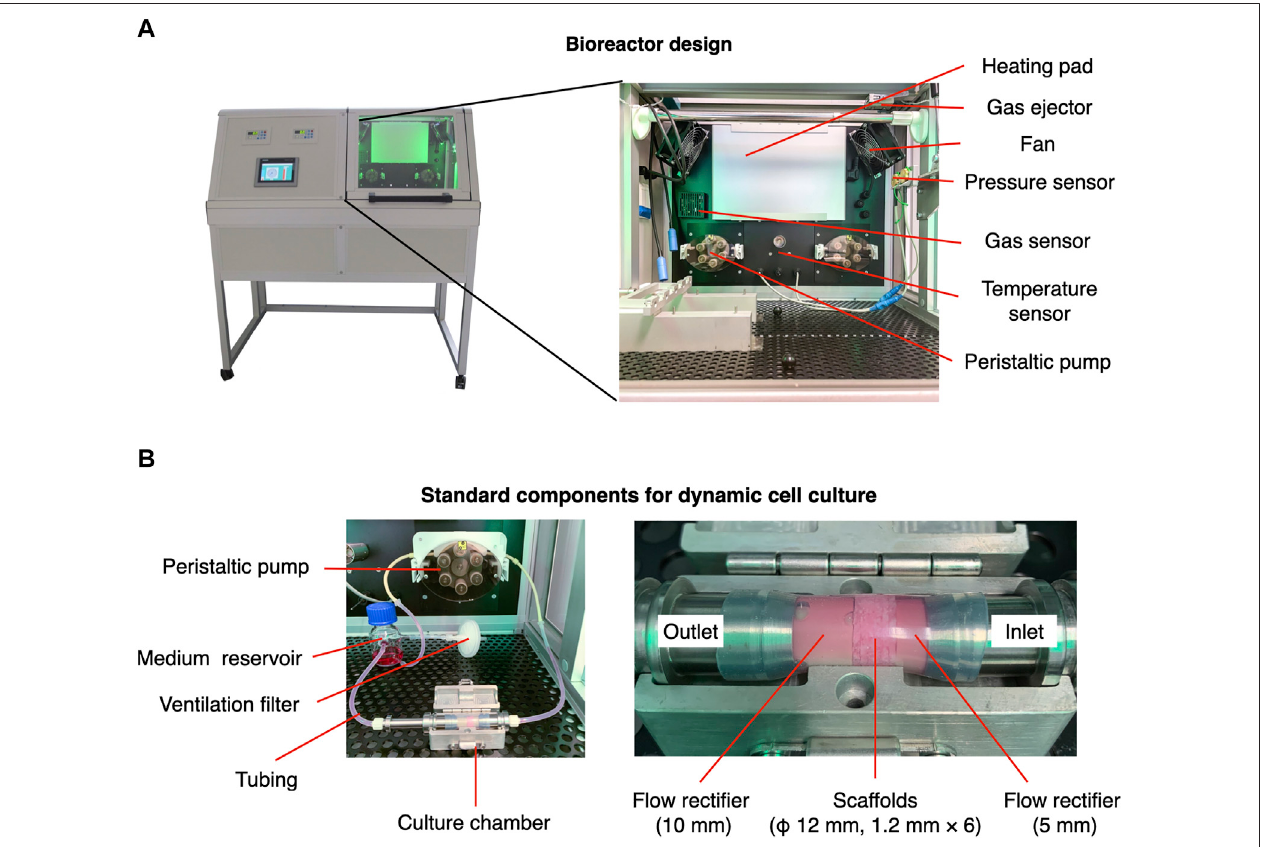
FIGURE 1 | Con fi guration of perfusion bioreactor used in the present study. (A) The bioreactor comprises a controlling/monitoring part (left) and an integrated incubator part (right). The integrated part is designed to maintain the desired temperature and gas concentration for cell culture. (B) A medium reservoir and culture chamber where scaffolds are placed are connected by silicon tubes. The fl ow velocity is controlled by a peristaltic pump.